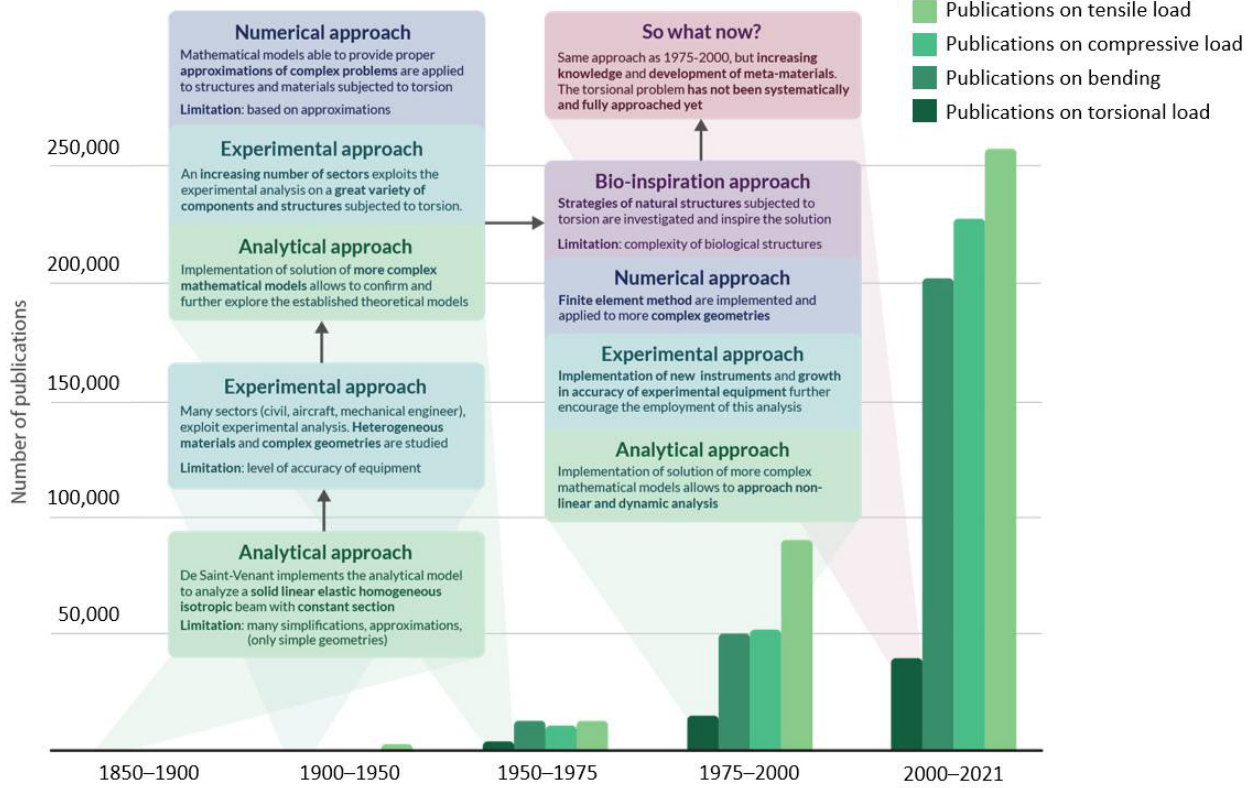
Figure 1. The infographic presents the evolution in approaching the torsional problem across years and the occurrence of publications dedicated to torsional analysis from 1850 until today. For each period, the comparison of torsional works with the papers dedicated to other commonly applied loads (tension, compression, and bending) is reported. The green boxes focus on the evolution of the analytical approach and their limitations; the light-blue boxes refer to issues related to the experimental approach. Violet boxes are dedicated to observations concerning the numerical approach, while the purple rectangle concerns bio-inspiration strategies. In pink, the latest trends in addressing the torsional problem are